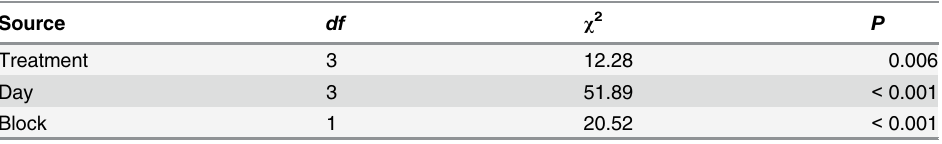
Table 4. Generalized linear model of the effects of different molecular-weight fractions of male acces- sory gland extract (treatment), the number of days after injection (days), and the experimental block (block) on the number of eggs dumped by females (N = 20 – 36 females per day, block and treatment group). Source df χ 2 P Treatment Day Block 1 20.52 < 0.001 Non-signi fi cant interactions were removed to avoid